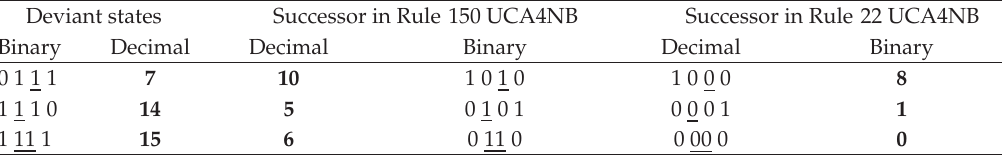
Table 8: Determination of deviant states and their successors for Rule 22